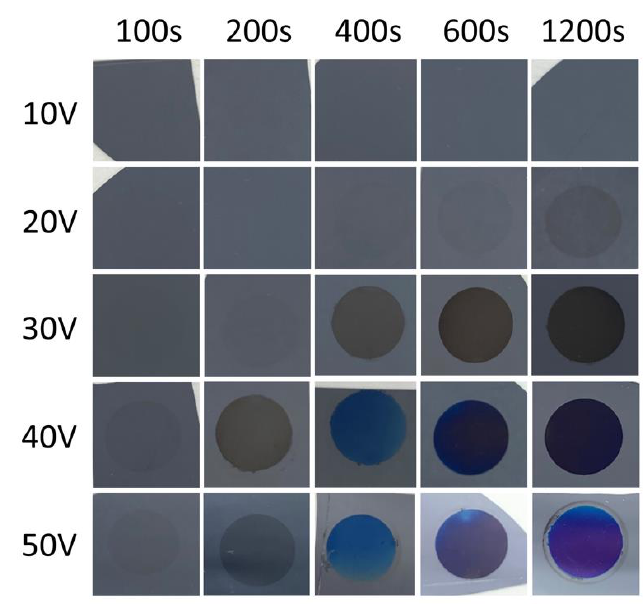
Figure 3. The optical photograph of the anodized Si wafers under different applied voltage.